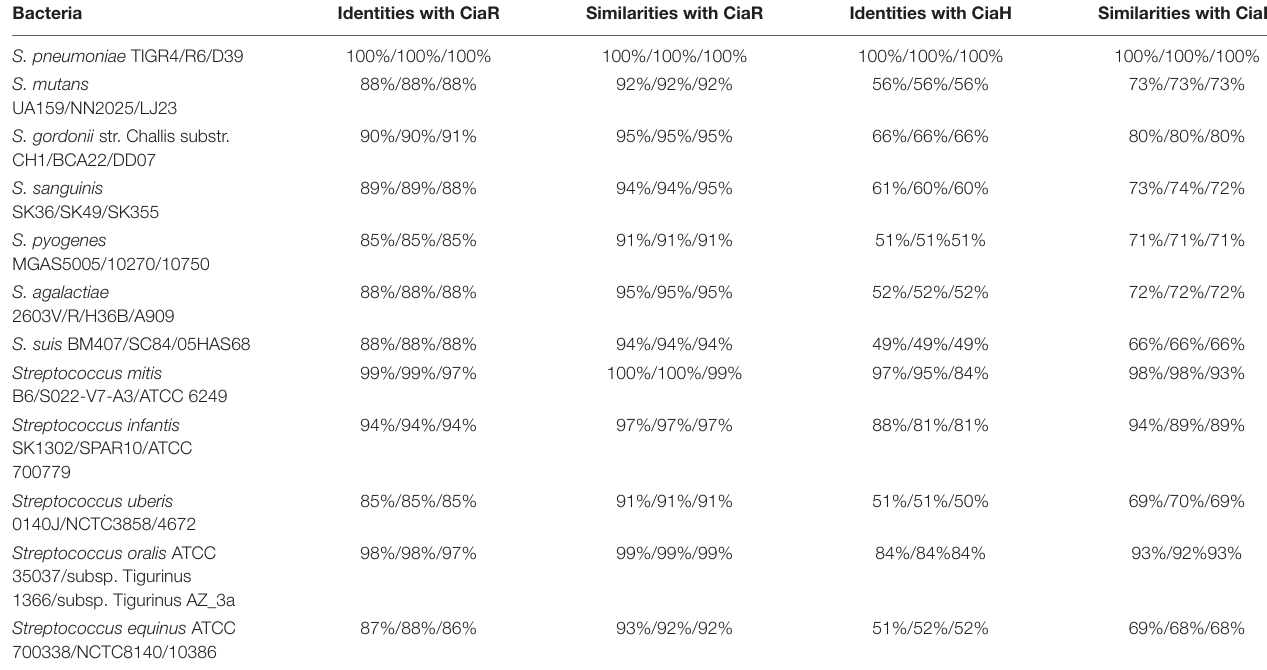
TABLE 1 | Amino acid identities and similarities of CiaR and CiaH proteins of various streptococci to S. pneumoniae TIGR4 CiaR and CiaH proteins. Bacteria Identities with CiaR Similarities with CiaR Identities with CiaH Similarities with